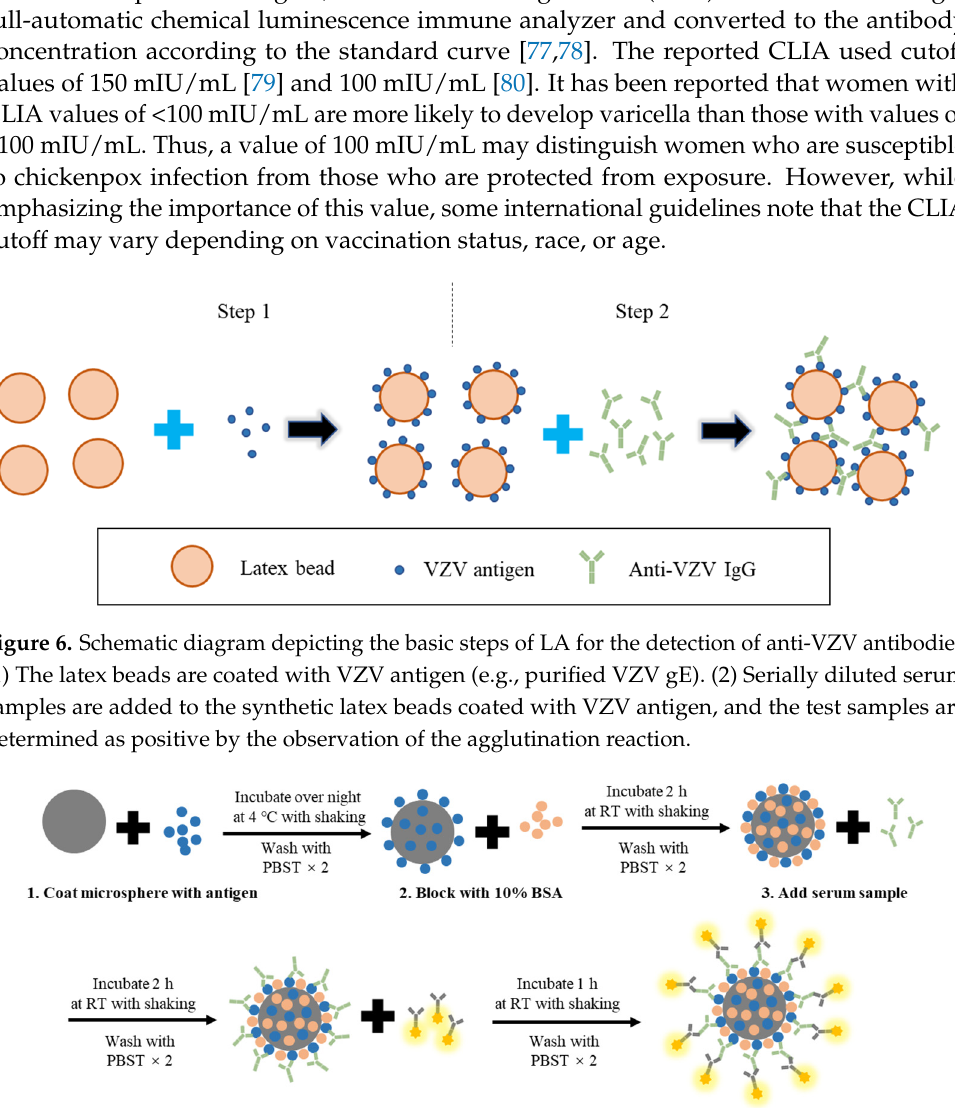
Figure 6. Schematic diagram depicting the basic steps of LA for the detection of anti ‐ VZV antibod ‐ ies. (1) The latex beads are coated with VZV antigen (e.g., purified VZV gE). (2) Serially diluted serum samples are added to the synthetic latex beads coated with VZV antigen, and the test samples are determined as positive by the observation of the agglutination reaction.